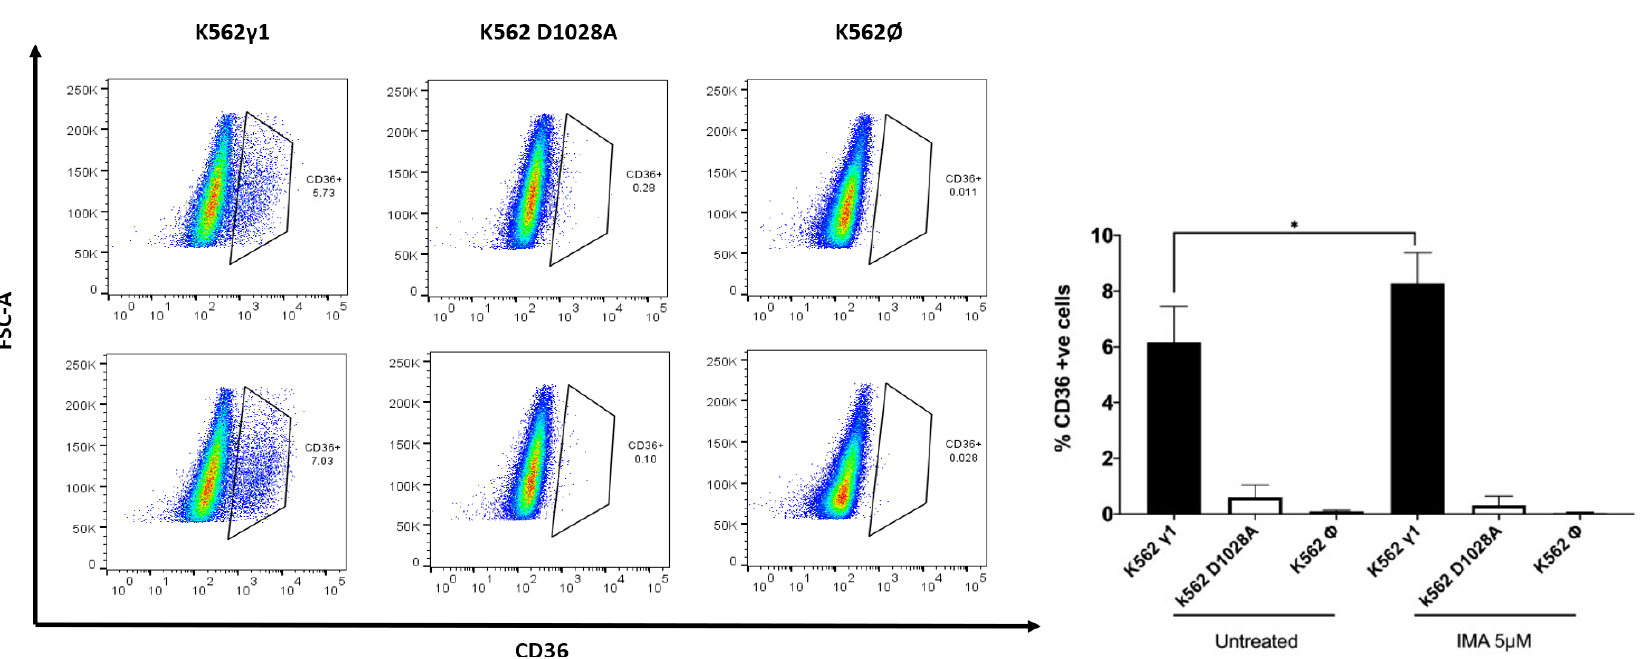
Figure 5. Flow cytometry analysis of CD36 + surface marker on K562 subclones. ( Left panel ): Representative dot plot graphs show the increased expression of CD36 on the surface of the K562 cell lines expressing PTPRG γ 1 compared to the control group (control ∅ and D1028A) in presence or absence of 5 µ M IMA overnight treatment. ( Right panel ): summary of the results of a minimum of 3 experiments ( p = 0.03, one-tail t -test). p -values less than 0.1 are summarized with one